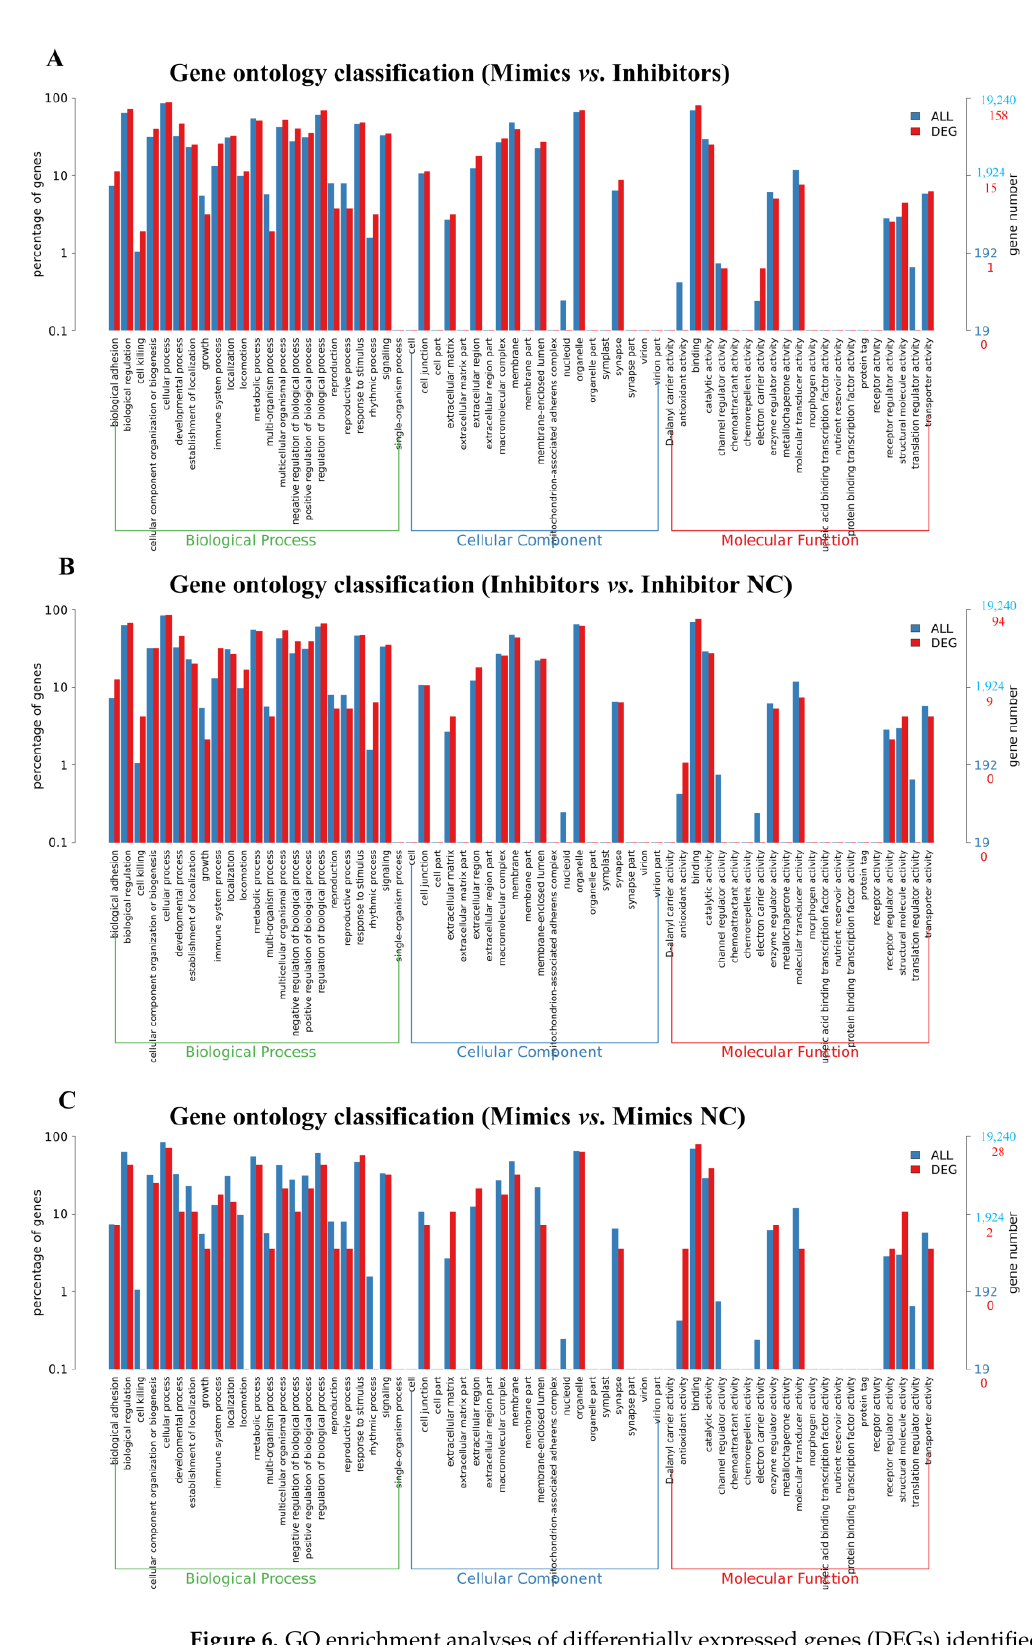
Figure 6. GO enrichment analyses of differentially expressed genes (DEGs) identified by RNA-seq in mouse NIH3T3 cells transfected with tRF-Trp-CCA-014 ( p < 0.05). ( A – C ) GO terms of Mimics vs. Inhibitors groups, Inhibitors vs. Inhibitor NC groups, and Mimics vs. Mimic NC groups, respectively. NC — negative control.